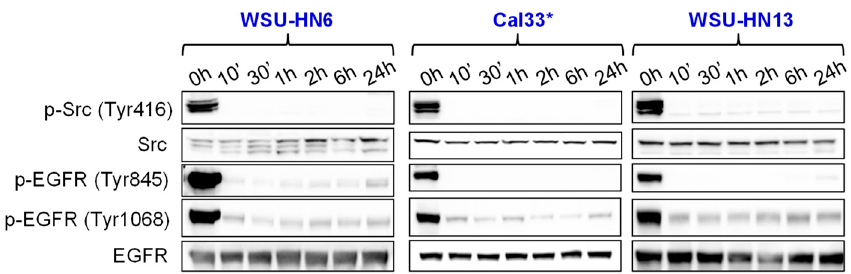
Figure 3. Western blot analysis of Src and EGFR phosphorylation of Bosutinib-sensitive HNSCC cell lines treated with the IC 50 of the drug at different time points. * Cell lines with mutations in PIK3CA .